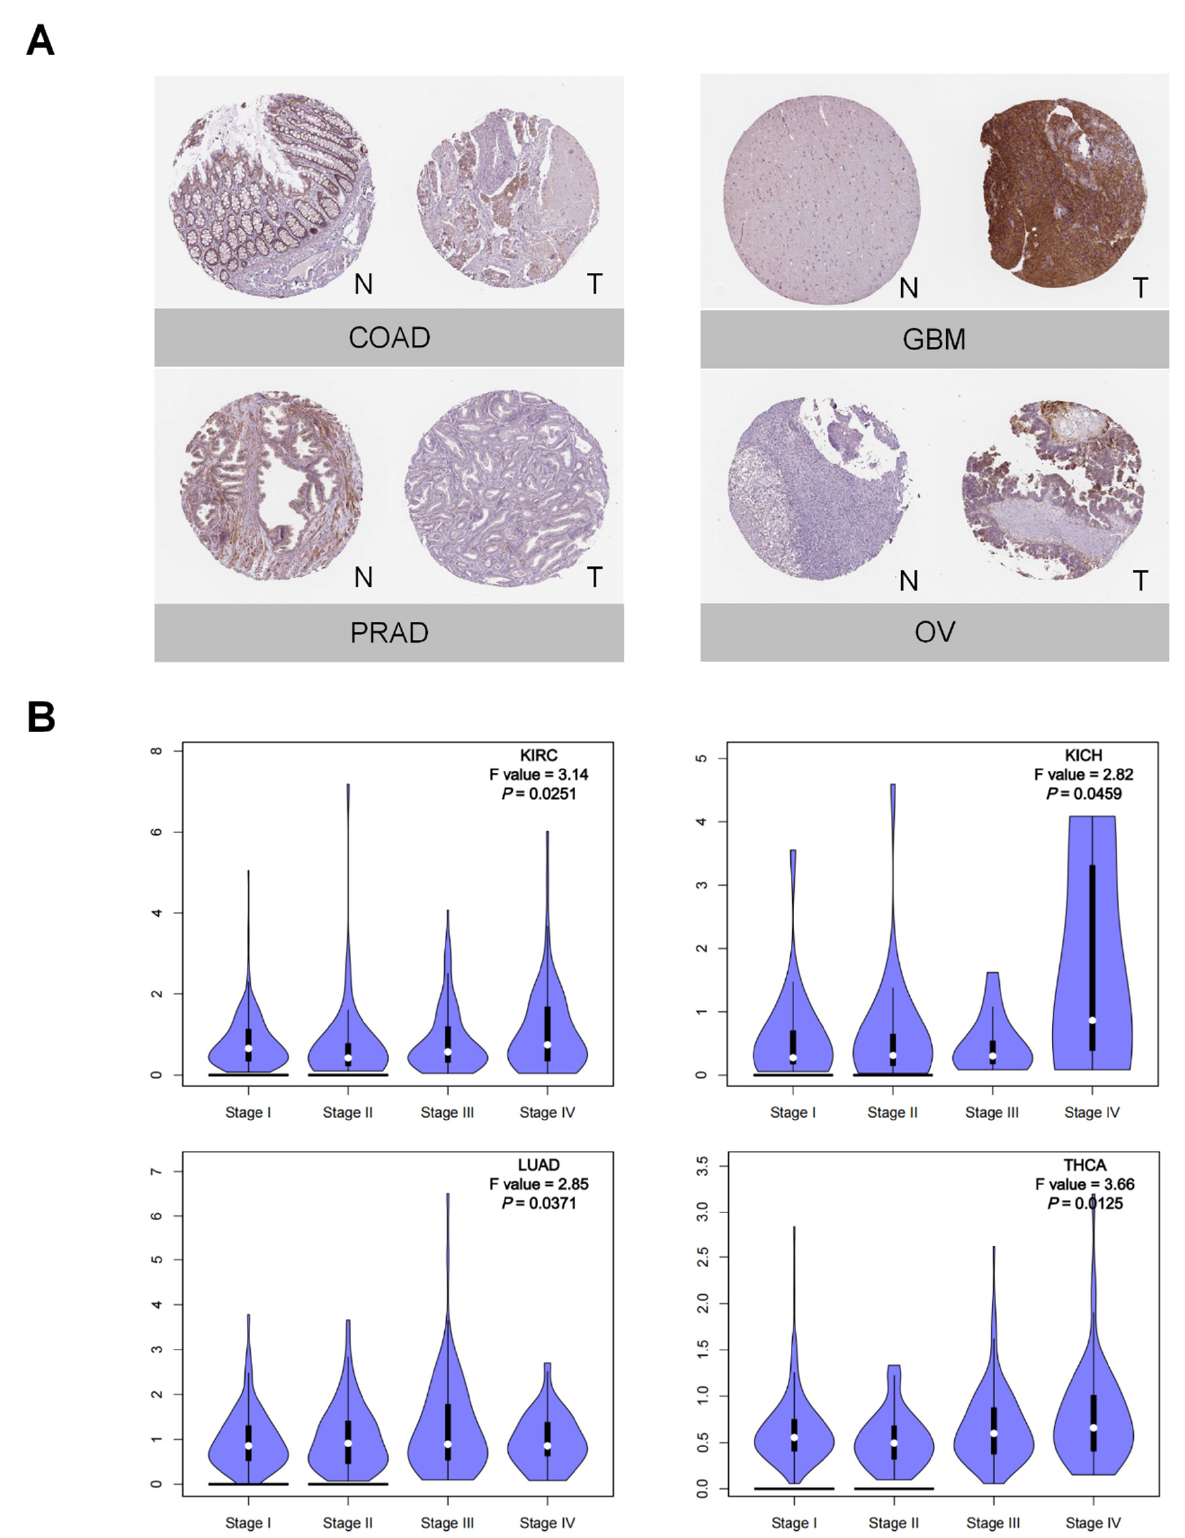
Figure 2. PTX3 protein expression and clinical features: ( A ) Representative immunohistochemical staining (IHC) images showed PTX3 protein expression in COAD, GBM, OV, and PRAD based on the HPA database (N, normal and T, tumor); ( B ) correlations between PTX3 and tumor stages in KIRC, KICH, LUAD, and